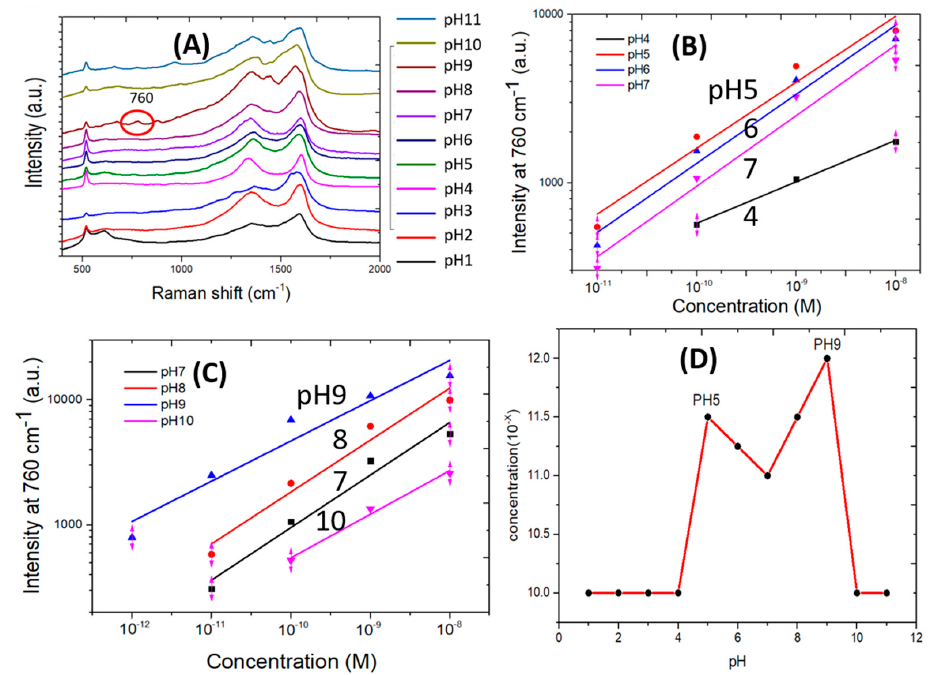
Figure 6. ( A ) SERS spectra measured for 10 − 12 M adenine water solution of different pH values. ( B , C ) Adenine SERS signal intensity as a function of adenine concentration and pH value. ( D ) Low detection limit of adenine concentration by the SERS sensor in study in water solution of different pH values.